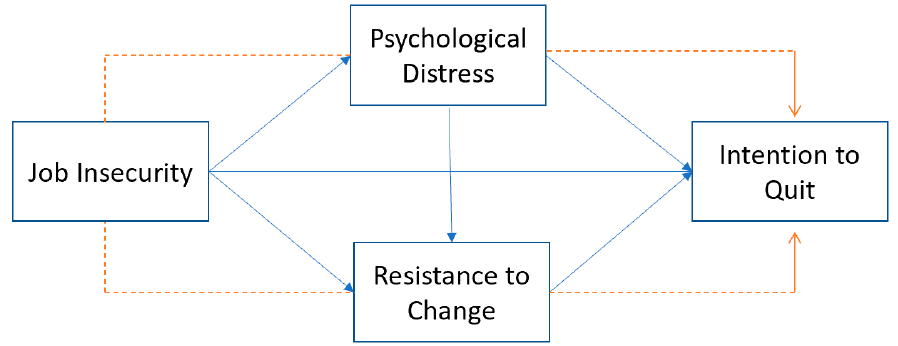
Figure 1. Conceptual framework.